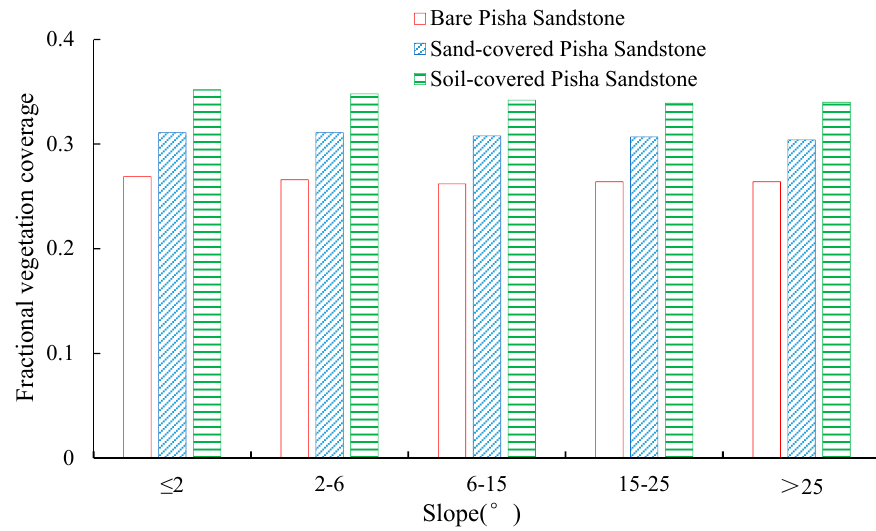
ff erent Pisha sandstone types.